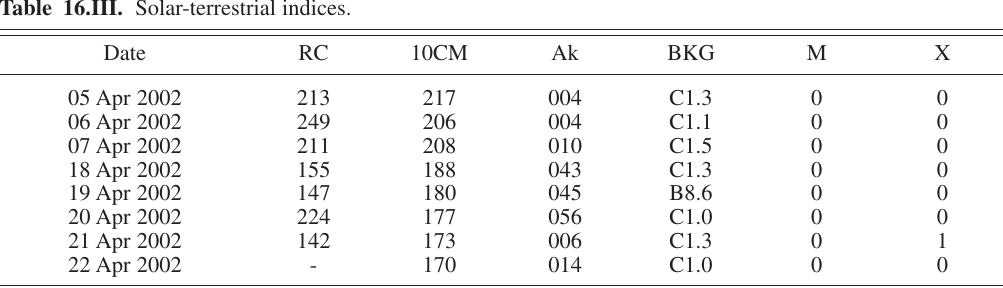
Table 16.III. Solar-terrestrial